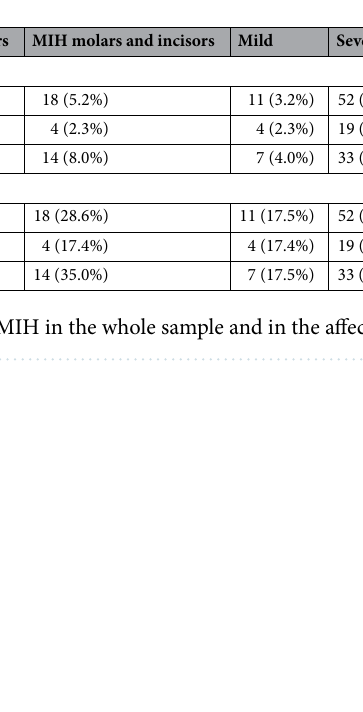
Table 2. Gender-based analysis in cases of MIH with exclusive molar location and in those with molar + incisor location.